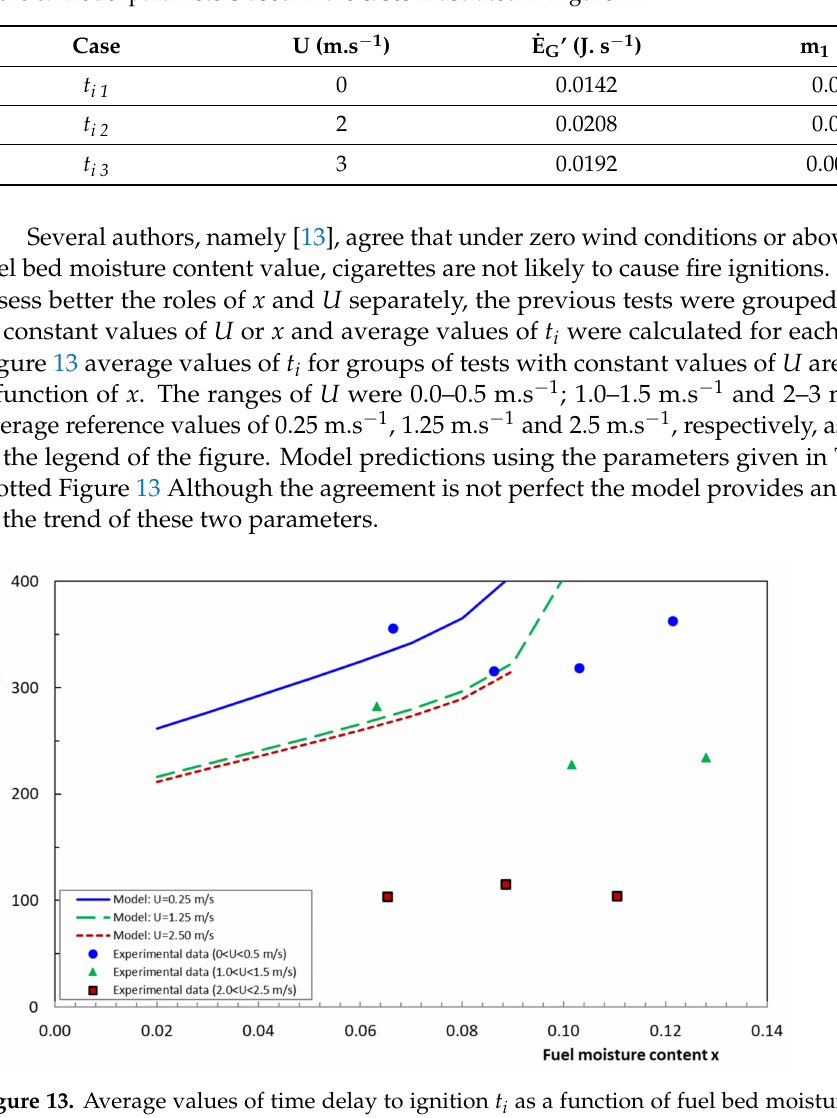
Table 6. Model parameters used in the cases illustrated in Figure 12.